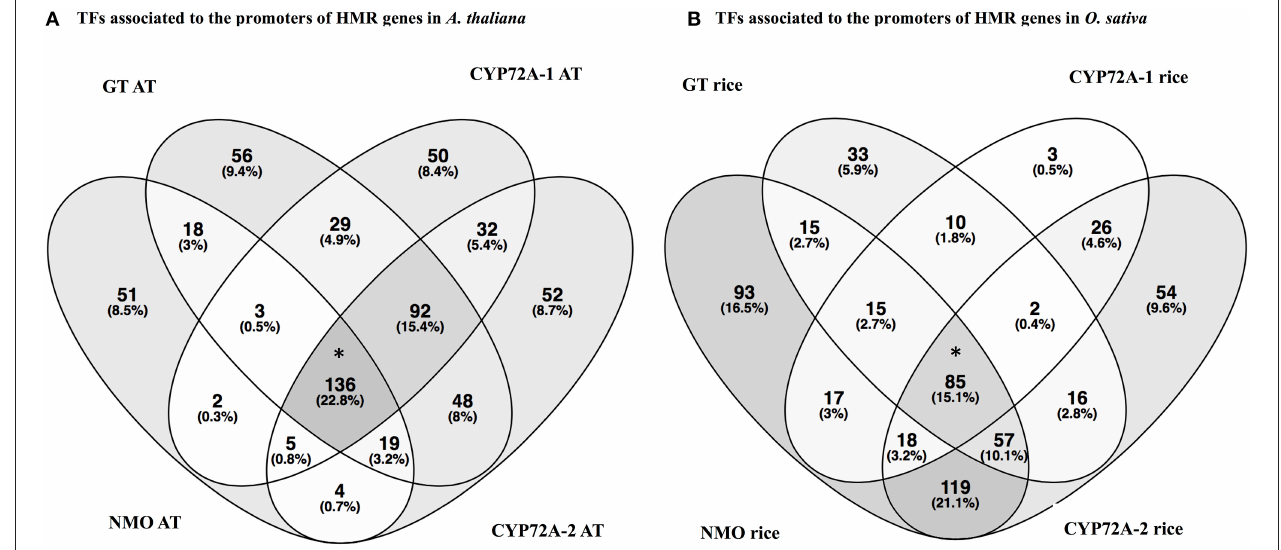
FIGURE 2 | Venn diagrams represent the transcription factors associated to the promoters of HMR genes of A. thaliana (A) and O. sativa (B). Analysis is done through The Plant Promoter Analysis Navigator (PlantPAN 2.0) using the promoter analysis function. (A) TFs associated to the promoters of HMR genes in Arabidopsis thaliana . (B) TFs associated to the promoters of HMR genes in Oryza sativa . *TFs associated to all four HMR genes of A. thaliana and O. sativa . One hundred and thirty-six TFs commonly associated to promoters of all four MR genes in A. thaliana and 85 TFs linked to the promoters of HMR genes of O. sativa . AT represents Arabidopsis thaliana. Venn diagrams were plotted using online tool Venny 2.0 http://bioinfogp.cnb.csic.es/tools/venny.